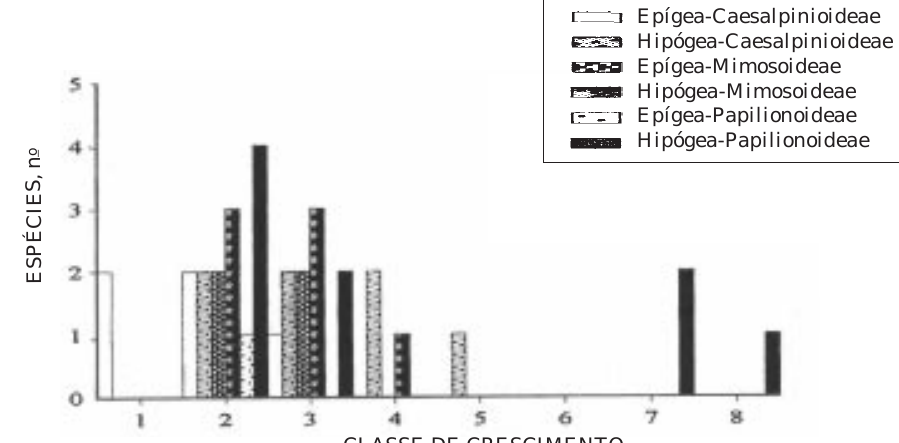
Figura 1. Número de espécies epígeas e hipógeas, oriundas de áreas inundadas, por classe de crescimento de mudas. Classe 1: inferior ou igual a 10 cm; Classe 2: de 10,1 a 30 cm; Classe 3: de 30,1 a 50 cm; Classe 4: de 50,1 a 70 cm; Classe 5: de 70,1 a 90 cm; Classe 6: de 90,1 a 100 cm; Classe 7: de 110,1 a 130 cm; e Classe 8: de 130,1 a 150